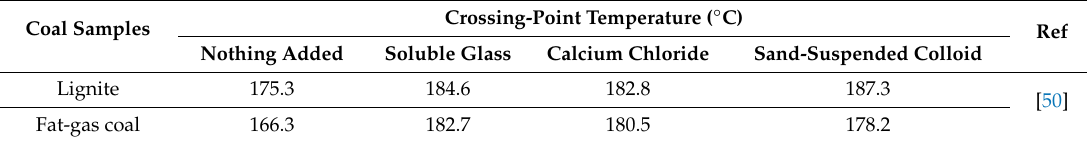
Table 1. Crossing-point temperature of coal samples.